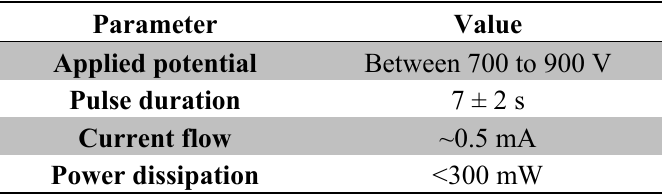
Table 3. Results from electrical lysis